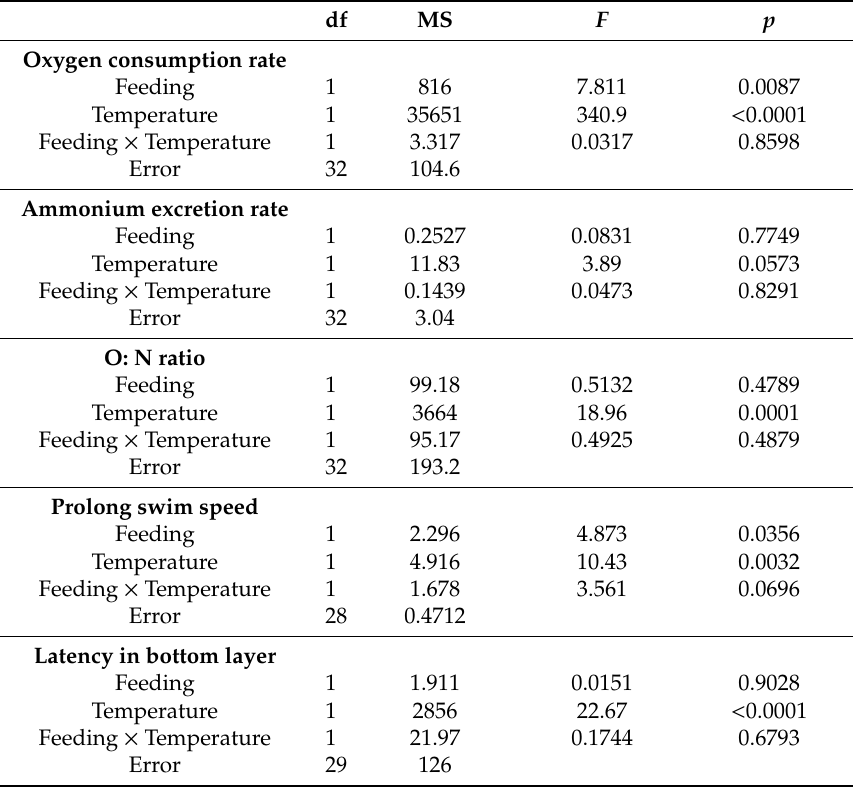
Table 2. Statistical comparisons (two-way ANOVA) of metabolic and behavioral parameters from tilapia fed with Ctrl or RSV-diets and maintained at 27 ◦ C or 15 ◦ C.